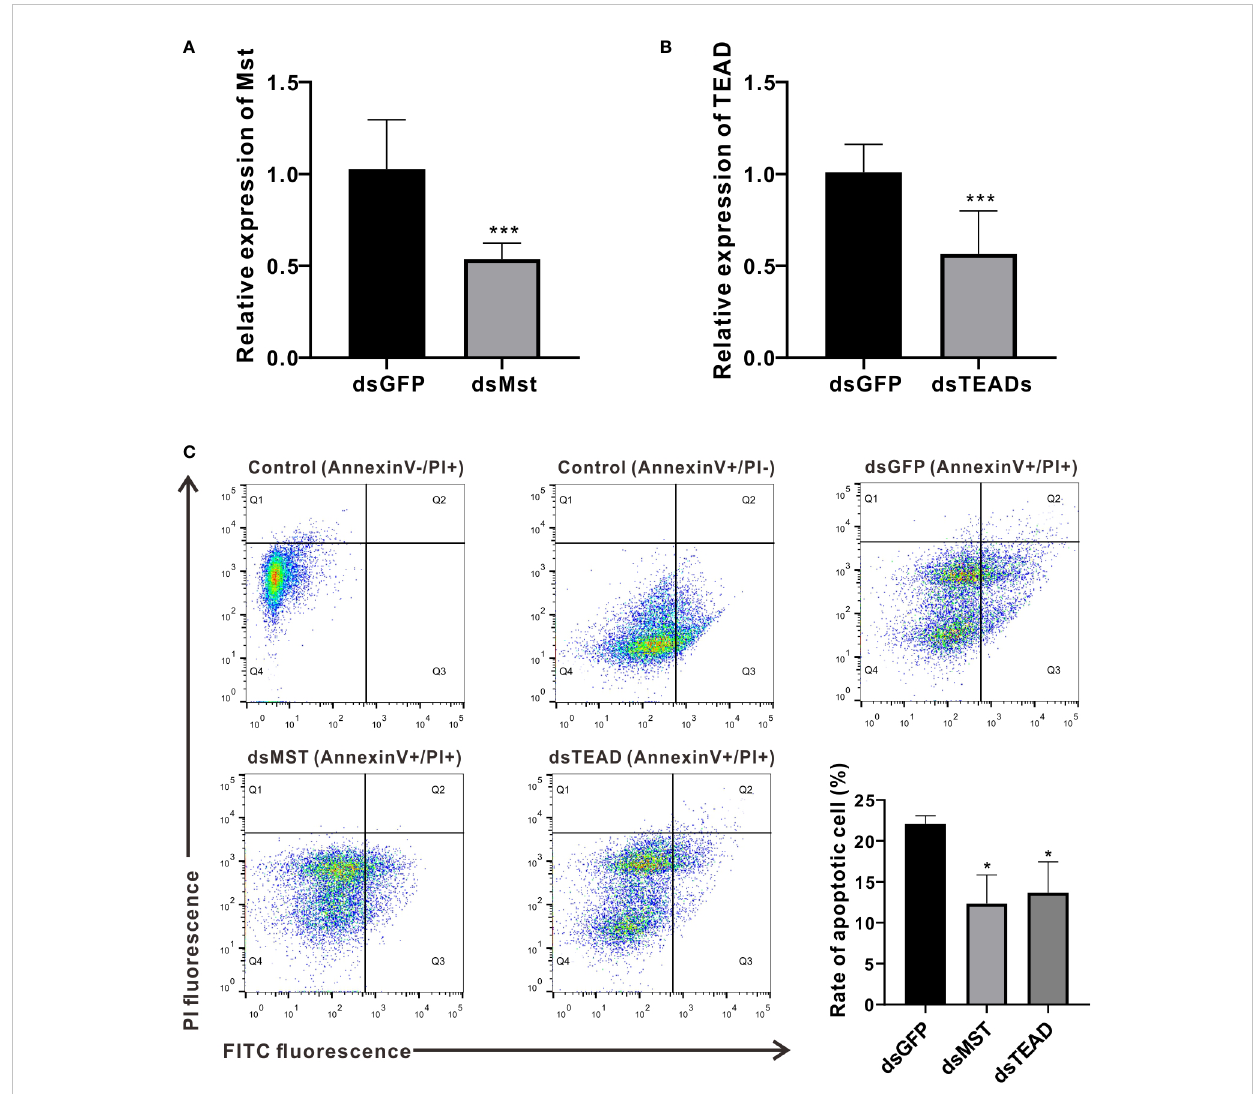
FIGURE 6 MST and TEAD gene participate in apoptosis. (A) Expression levels of Ch MST after RNA interference. (B) Expression of Ch TEAD after RNA interference. (C) Flow cytometry was used to detect hemocytes apoptosis after knockdown of Ch MST and Ch TEAD. Q1: Cells that were stained positively with PI only (upper left quadrant) were necrotic/non-viable cells. Q2: Cells that were stained double-positively by Annexin V-FITC and PI (top right quadrant) were cells undergoing late apoptosis/necrosis. Q3: On the lower right quadrant were cells stained positively by Annexin V only, representing cells undergoing early apoptosis. Q4: The lower left quadrant (PI and Annexin V negative cells) shows live cell populations. Lower right panel displayed the rate of apoptosis cells after Ch MST and Ch TEAD knockdown. Data analysis was performed by using GraphPad Prism 9 software, and vertical bars represent mean ± SD ( n = 3). *** p < 0.001; * p <